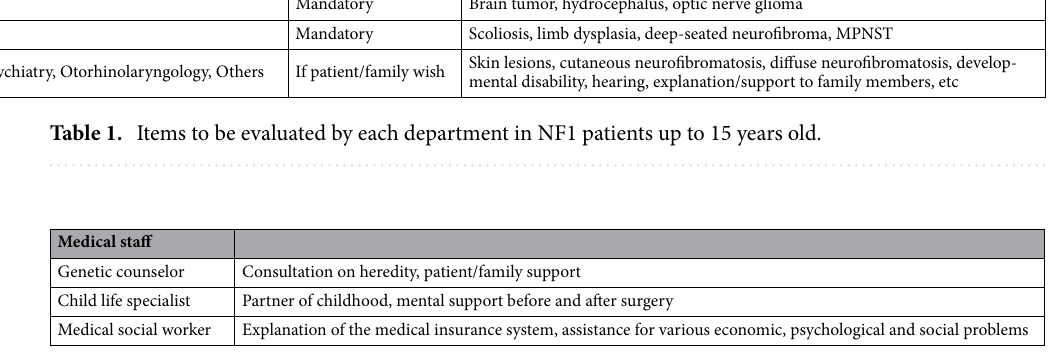
Table 2. Medical staff involved in NF1 medical care and related items.